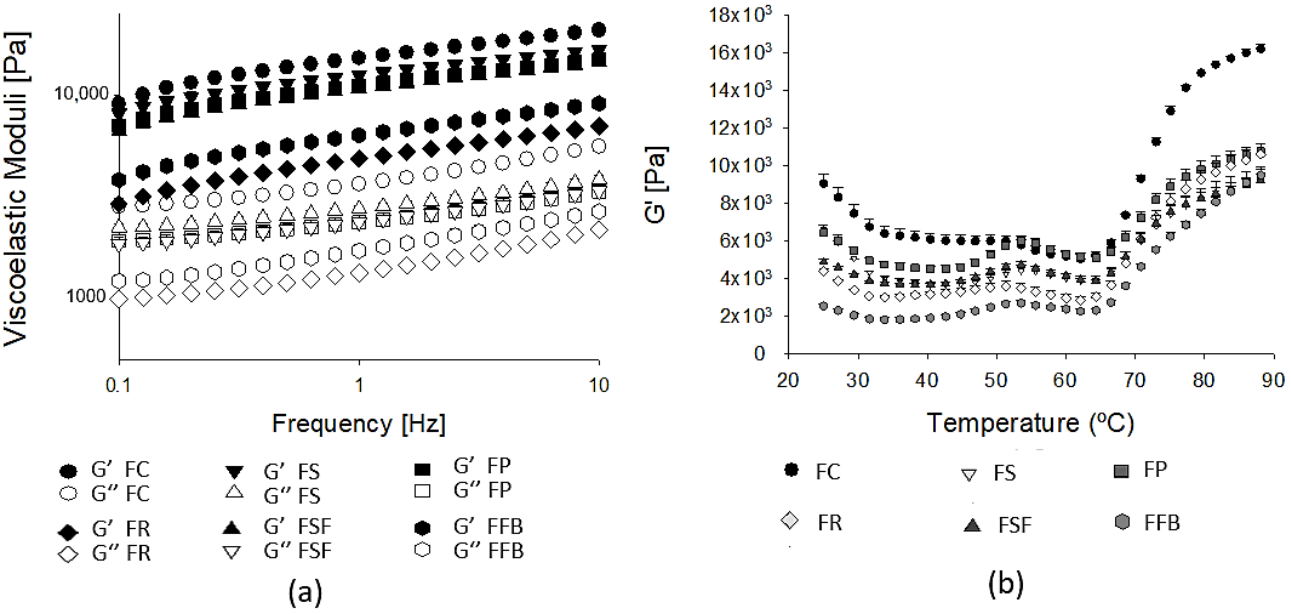
Figure 2. Frequency sweep ( a ) and temperature sweep ( b ) of hybrid meat emulsions elaborated with plant proteins as partial meat substitutes. G′ : storage modulus, G ″ : loss modulus. FC: control; FS: soy; FP: pea; FR: rice; FSF: sunflower; FFB: fava bean.